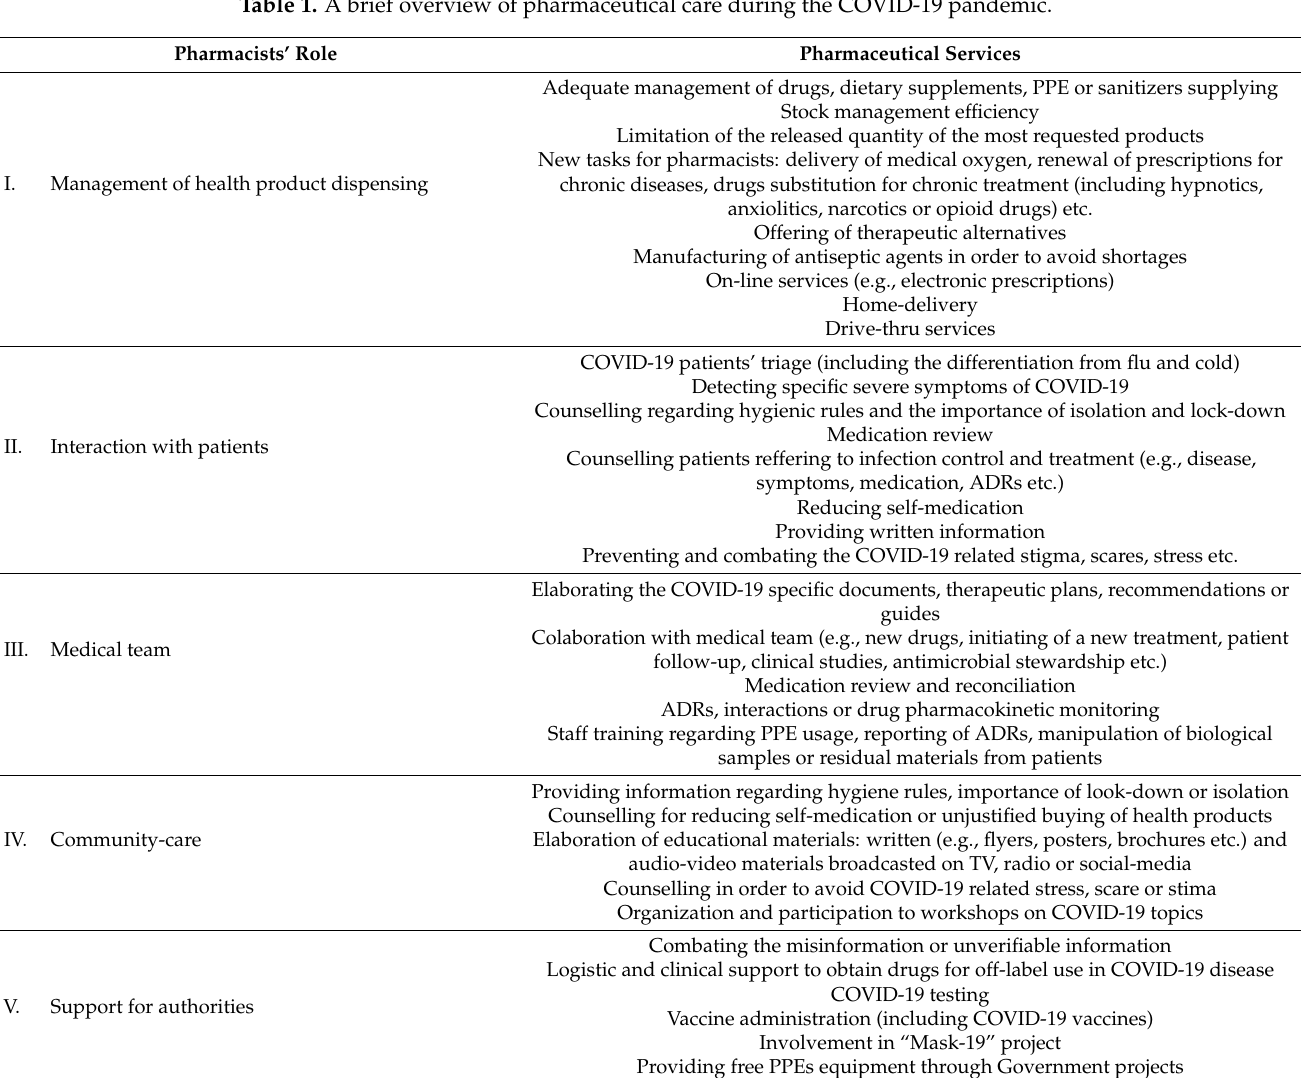
Table 1. A brief overview of pharmaceutical care during the COVID-19